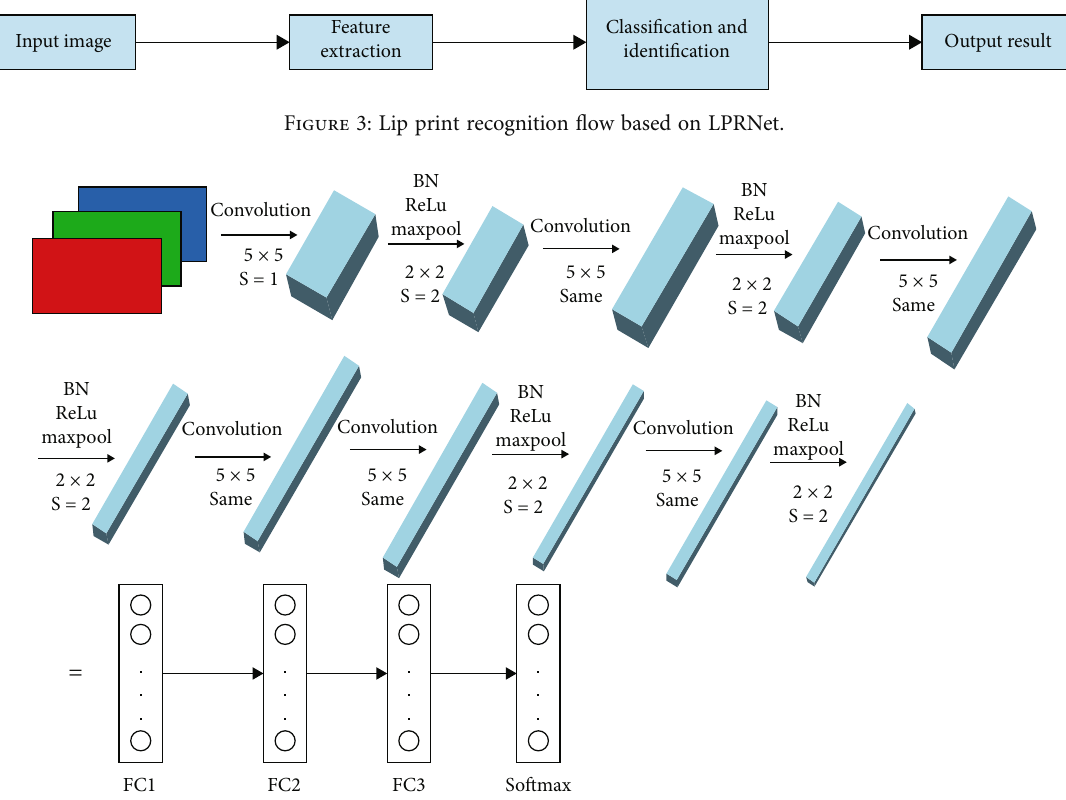
Figure 4: LPRNet network